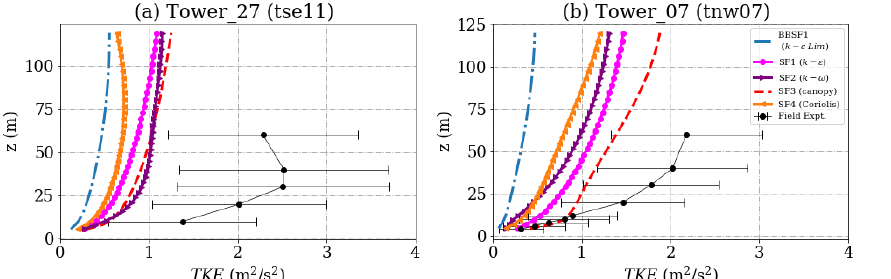
Figure 12. Simulation results and experimental data for turbulent kinetic energy inside the valley for (a) Tower 27 (tse11) and (b) Tower 7 (tnw07). The locations of the masts are given in Fig.